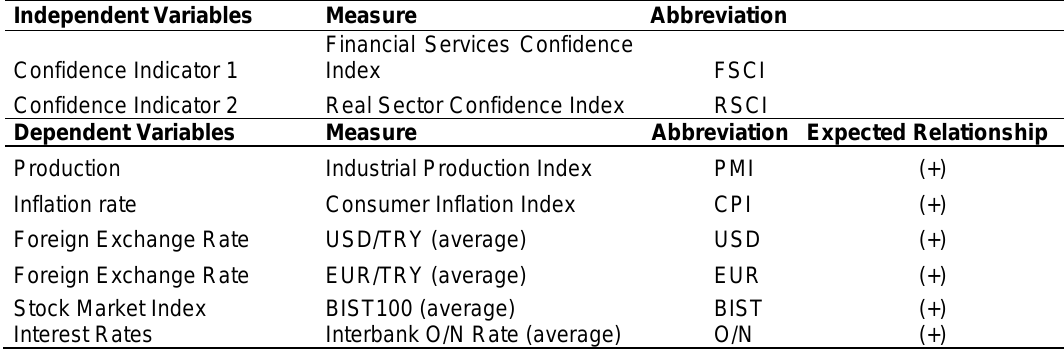
Interbank O/N Rate